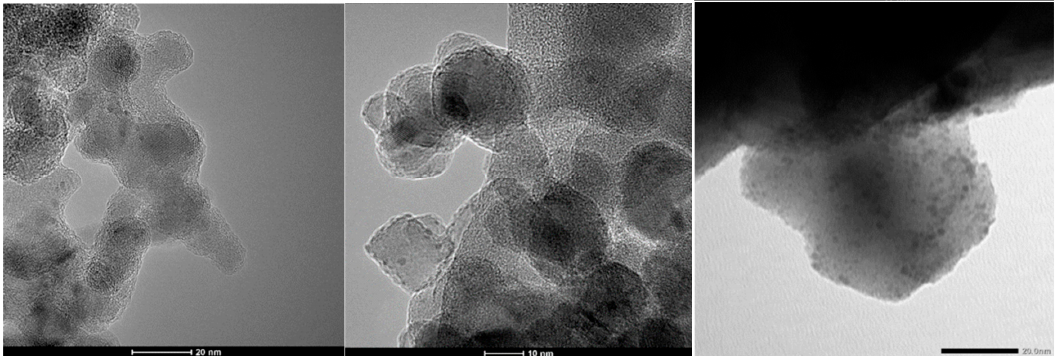
Figure 1. Transmission Electron Microscopy (TEM) images from left to right: Rh/Al 2 O 3, Rh/TiO 2, Rh/WO 3 . Reprinted with permission from Ref. [28]. Copyright 2021 IOSR Journals. Table 1. The fractal dimensions obtained by TEM analysis (using two different methods, the correla- tion function method (C) and the variable length-scale method (V), differ from the fractal dimensions obtained by fitting the experimental adsorption isotherms with the DR isotherms (in the capil- lary condensation regime) [28,29]. Reprinted with permission from Refs. [28,29]. Copyright 2021 IOSR